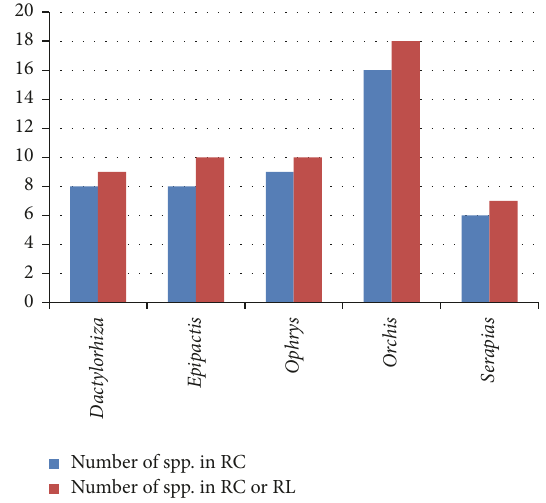
Figure 3: Genera with the highest number of species included in the regional catalogues. At the same time, the numbers of species included in regional catalogues and regional red lists are